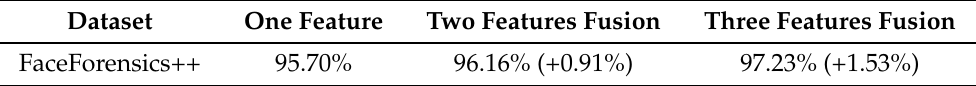
Table 7. Comparison of accuracy of features fusion of different layers on the FaceForensics++ dataset.